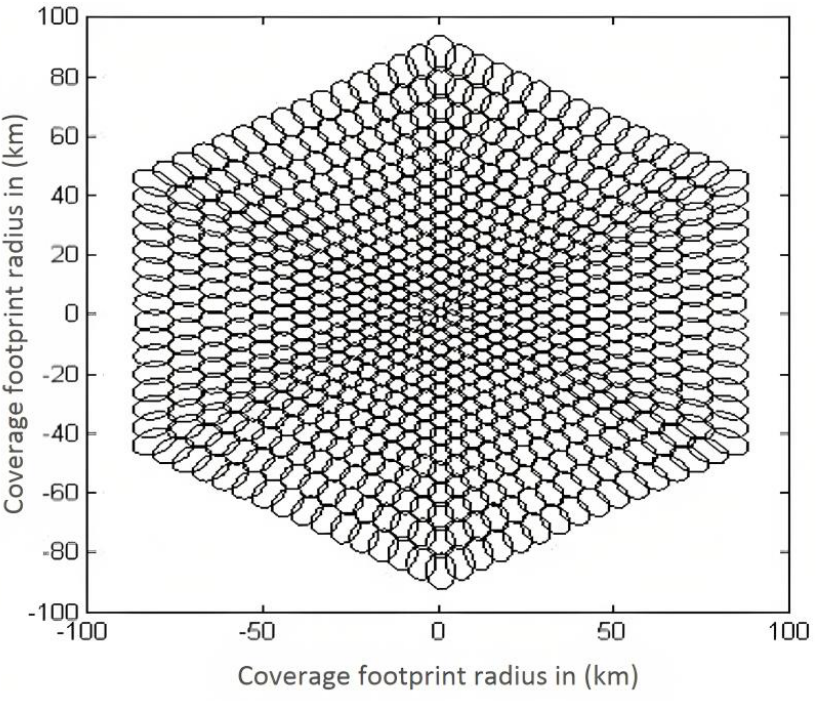
Figure 9. Non-optimized cellular structure layout for Riyadh.